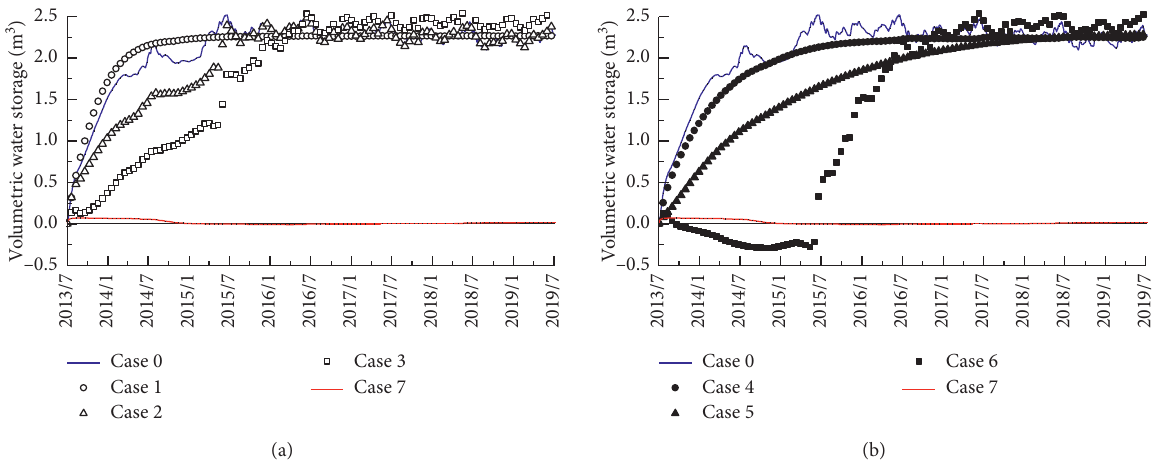
Figure 11: Comparison of volumetric water storage for a different combination: (a) cases 0, 1, 2, 3, and 7; (b) cases 0, 4, 5, 6, and 7.